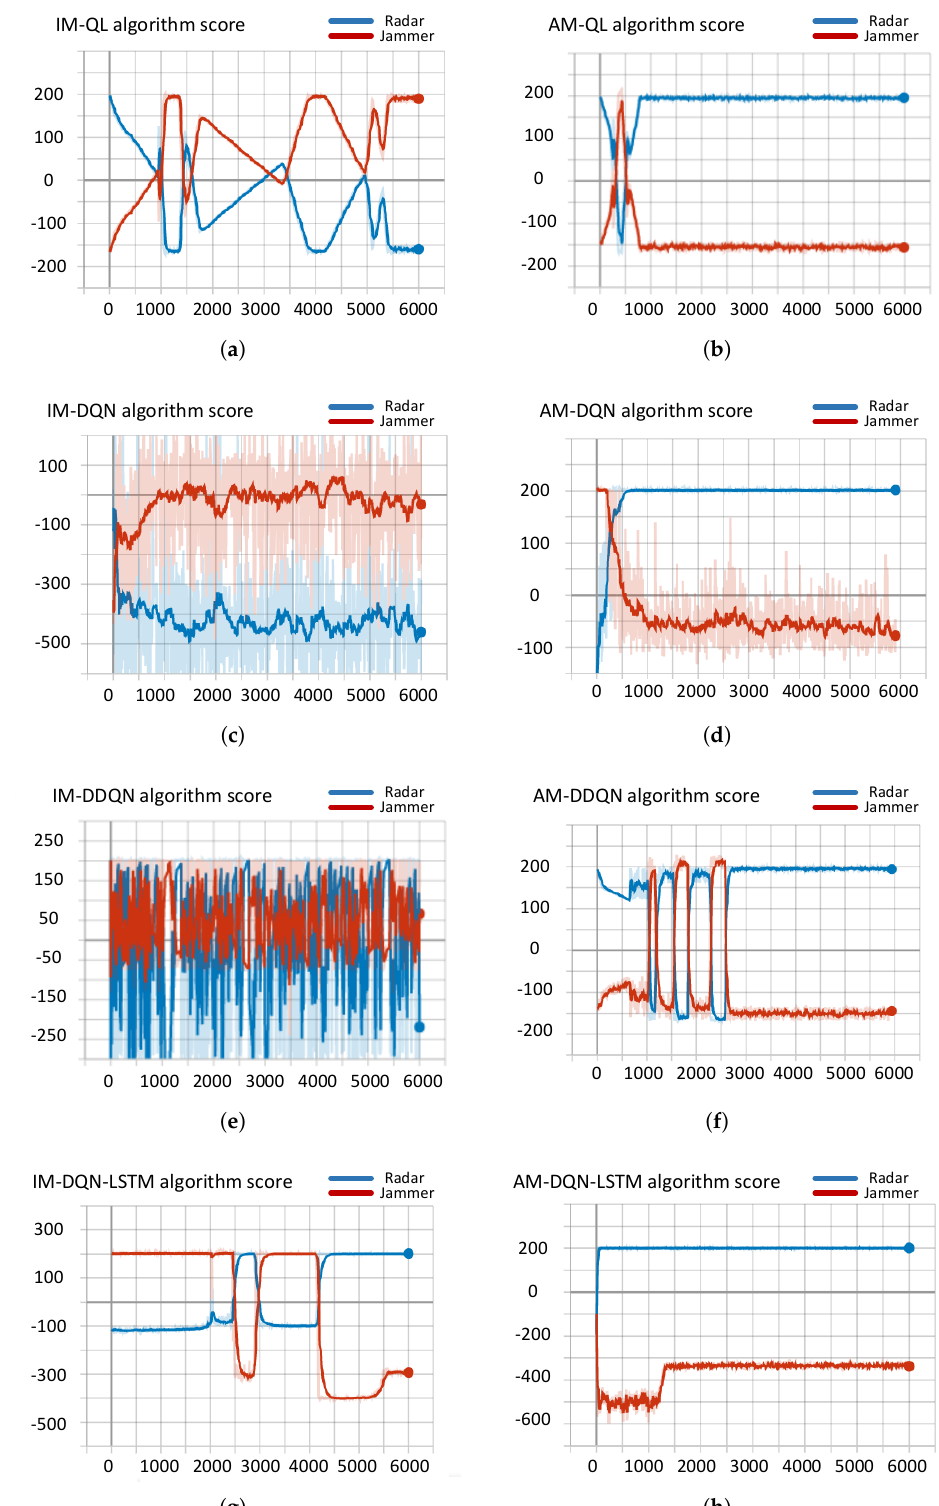
Figure 9. Comparisonof anti-jamming effects of classic RL algorithms under IM and AM mod- els. ( a ) IM-QL, ( b ) AM-QL, ( c ) IM-DQN, ( d ) AM-DQN, ( e ) IM-DDQN, ( f ) AM-DDQN, ( g ) IM- DQN+LSTM, ( h )